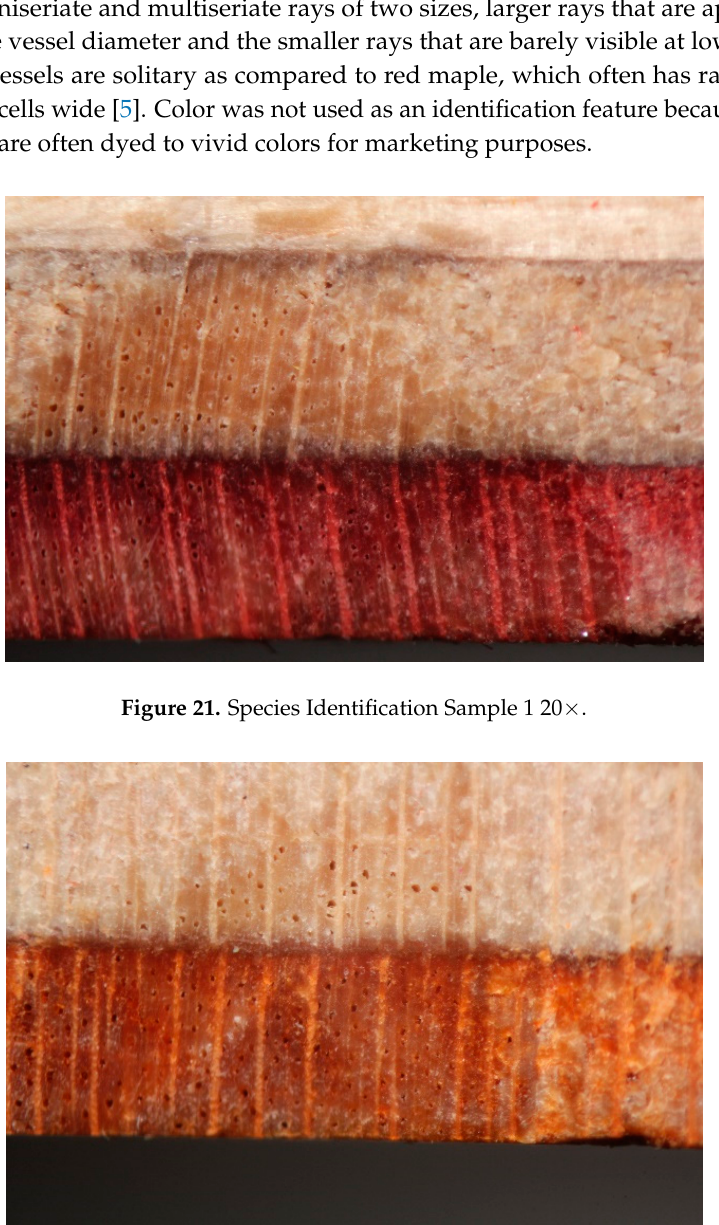
Figure 22. Species Identification Sample 2 20×.